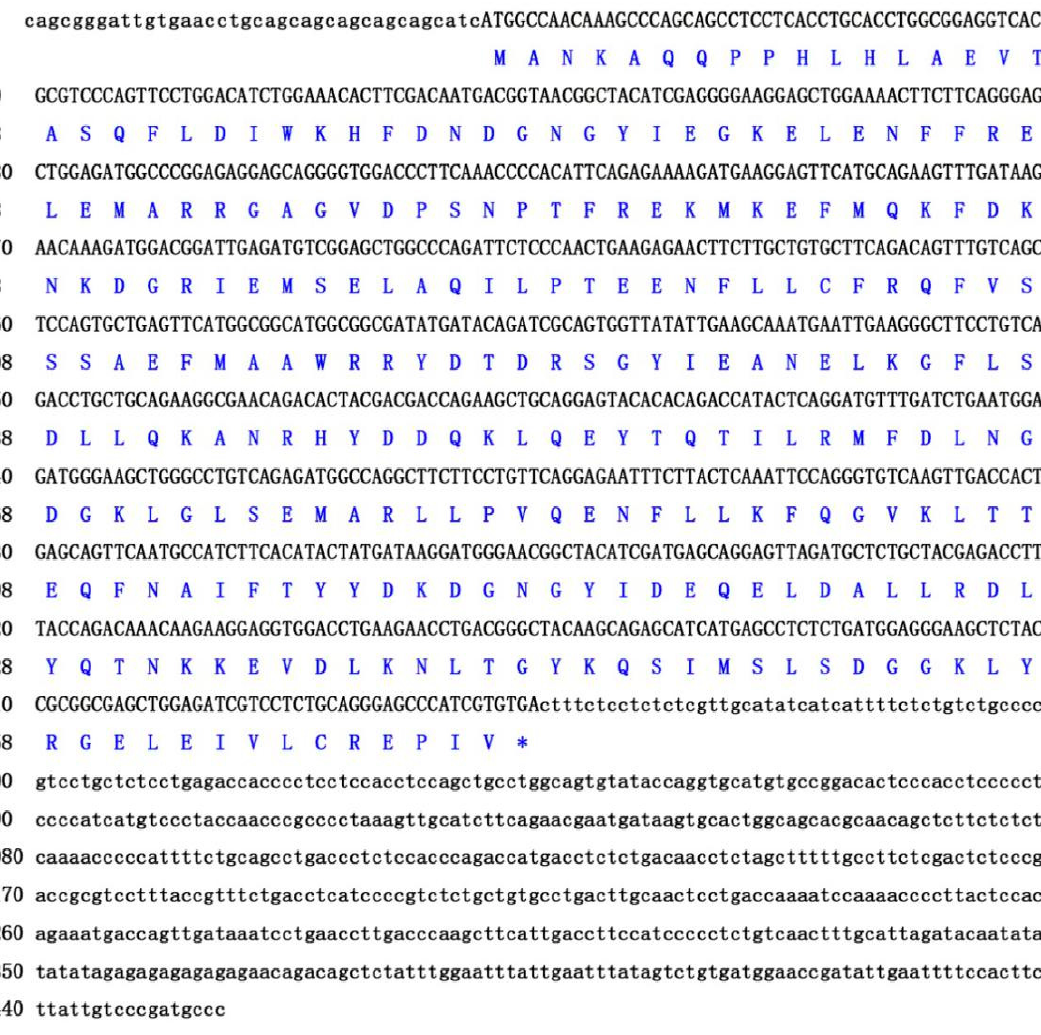
Figure 1. The cDNA and amino acid sequences of calb 2 in Paralichthys olivaceus. * indicates a stop codon.